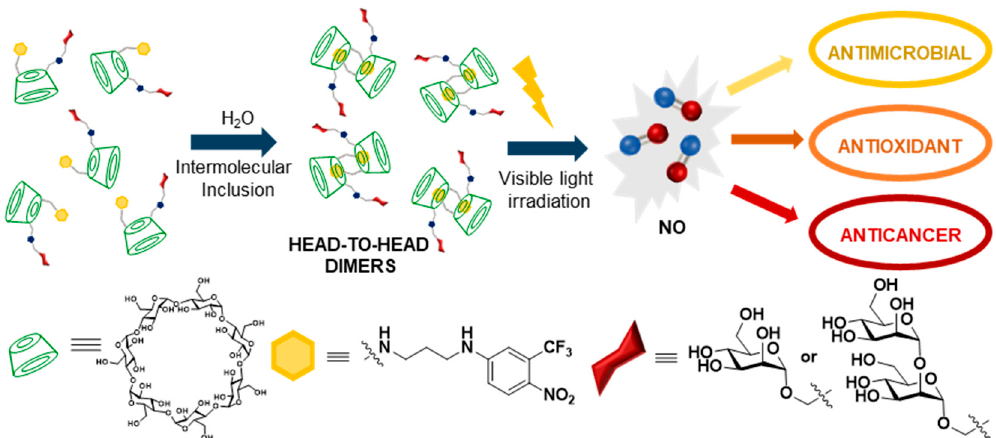
Figure 11. Structures and schematic representation of the functional supramolecular glycosystems developed by Vargas-Berenguel and coworkers for targeted nitric oxide-based therapies [80]. NO, nitric oxide.